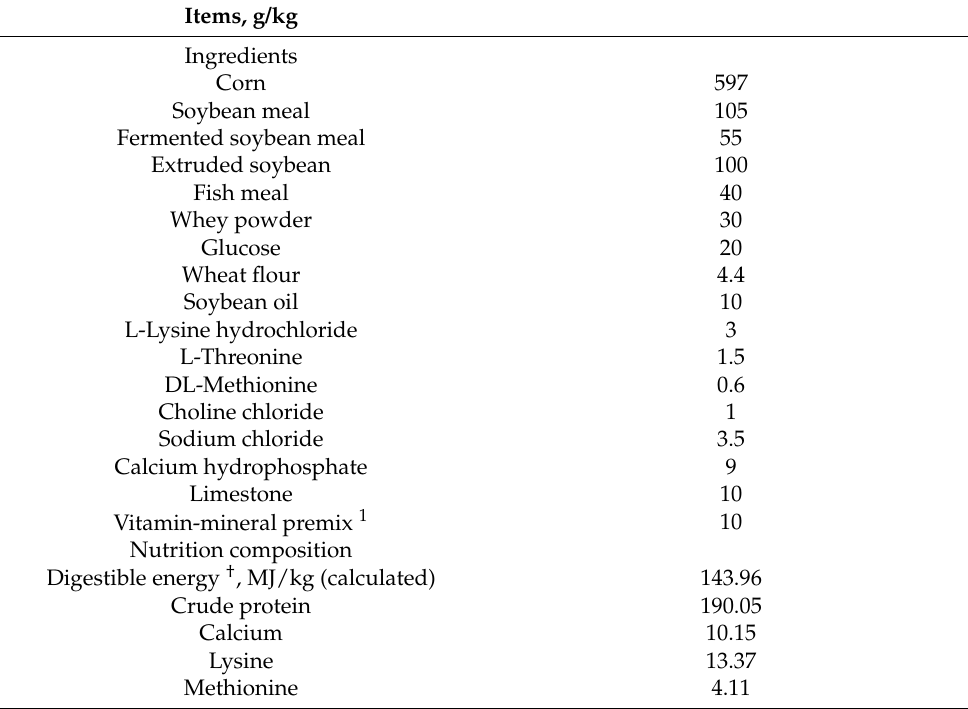
Table 1. Basal diet ingredients and chemical